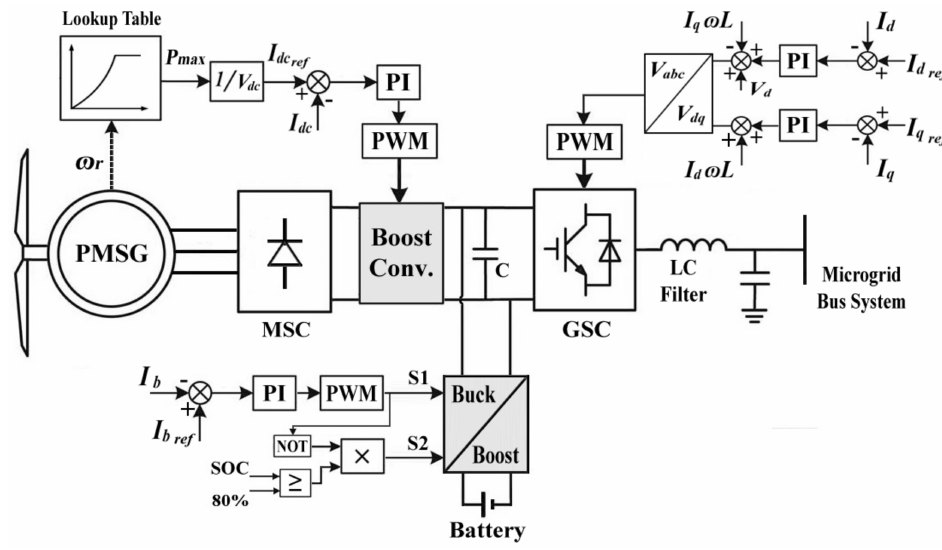
Figure 2. Structure and control system of WECS